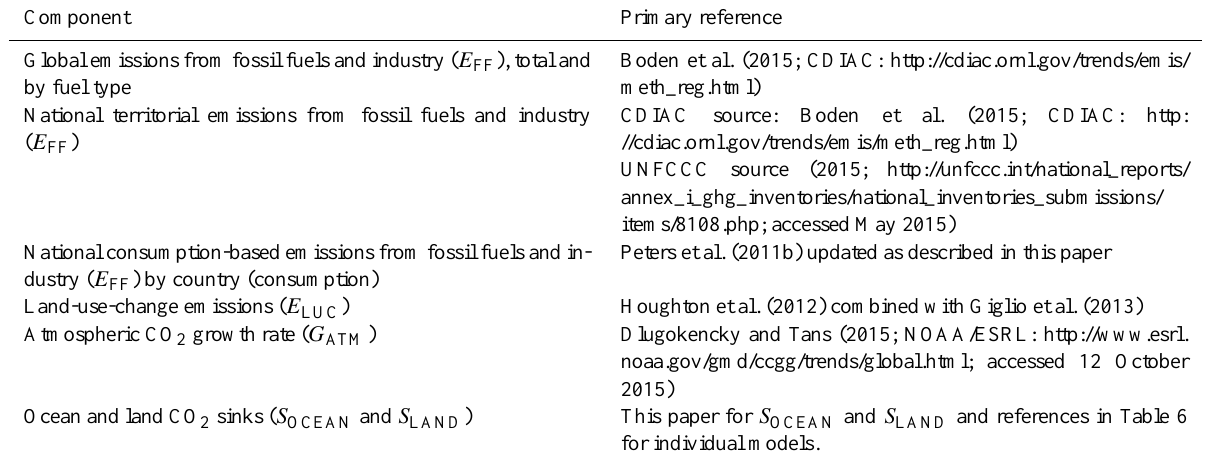
Table 2. How to cite the individual components of the global carbon budget presented here. Component Primary reference Global emissions from fossil fuels and industry ( E FF ), total